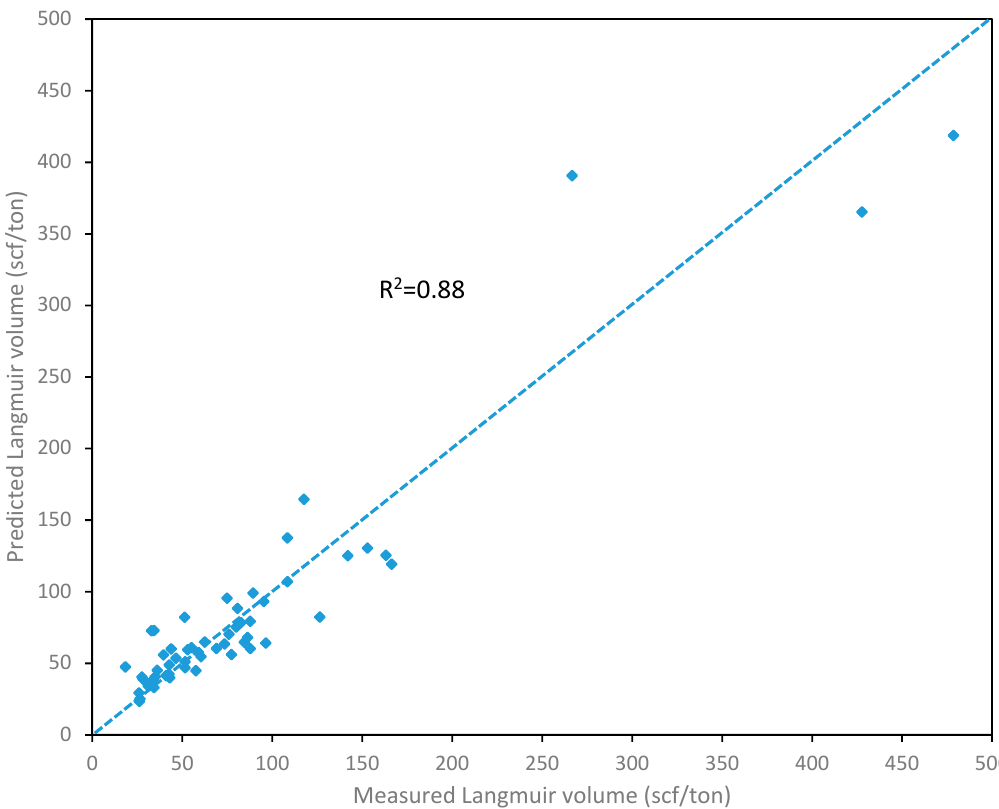
Measured Langmuir volume (scf/ton) Figure 5. The relationship between the measured and predicted Langmuir volume at experimental temperature.